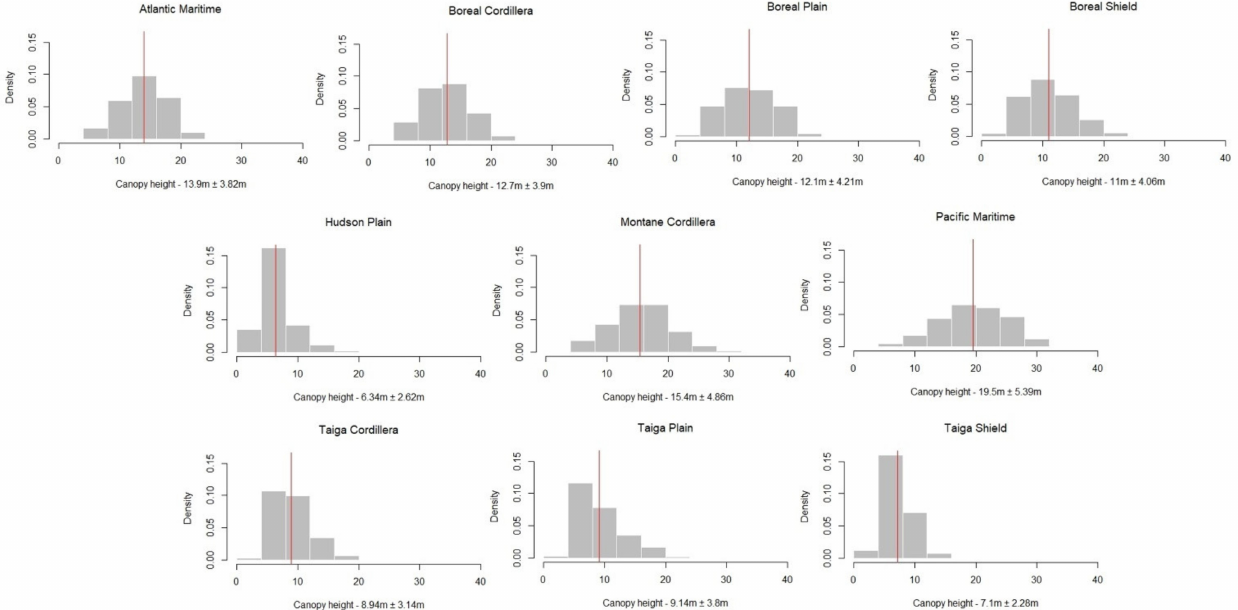
Figure 5. Distribution of canopy height values for Canada’s ecozone according to canopy height map produced from GEDI data. Note: red line indicates canopy height average; mean ± standard deviation is described in the bottom of each histogram.